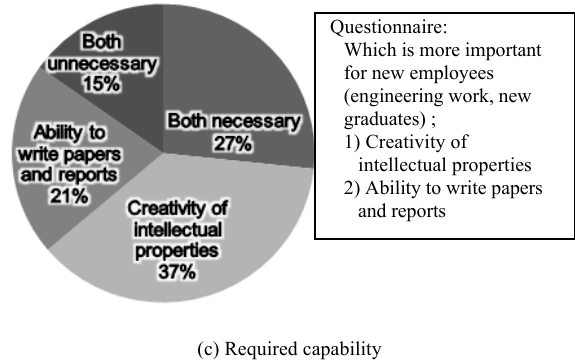
Figure 1. Questionnaire results of companies about questionnaire results about the perception of patents and research papers from the student’s point of view